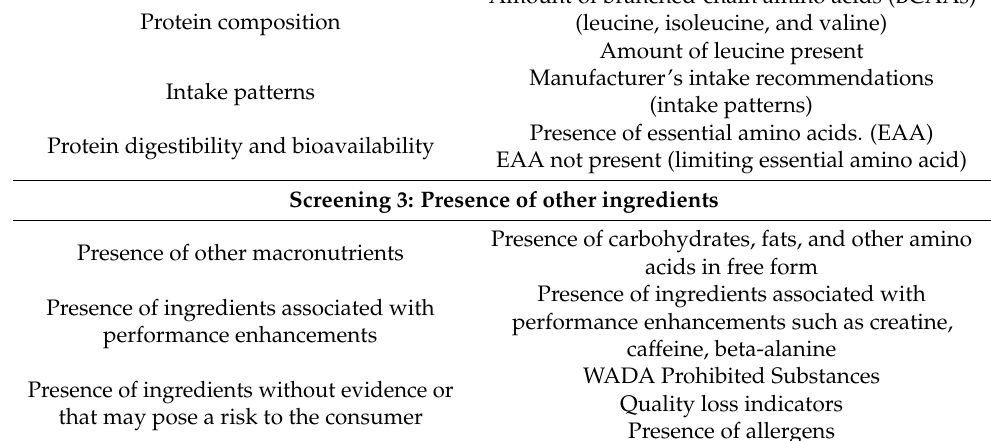
Screening 3: Presence of other